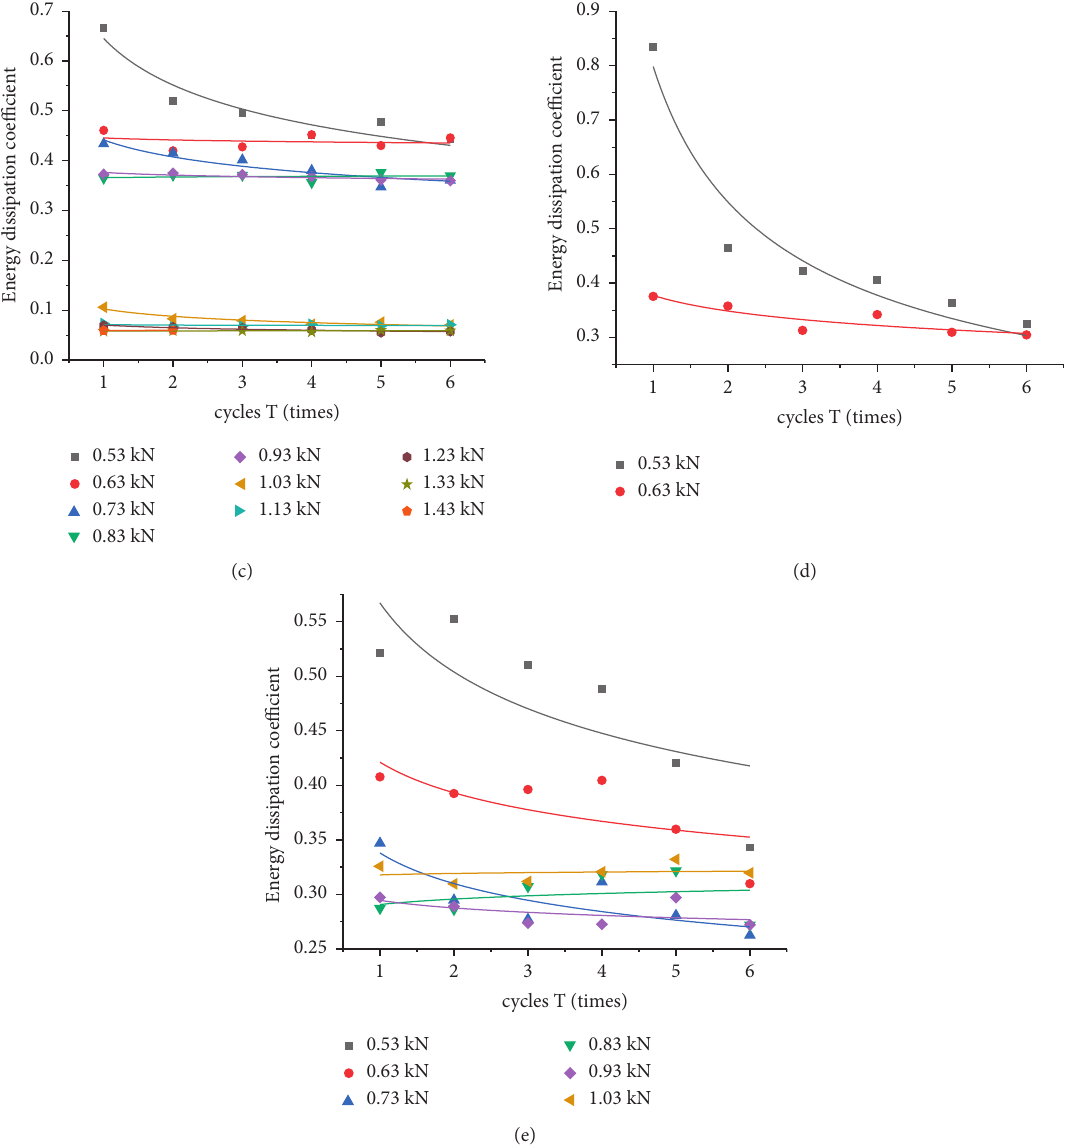
Figure 16: Relationship between energy dissipation coefficient and cycle times. (a) LK1. (b) LK2. (c) LK3. (d) ZZ1. (e)